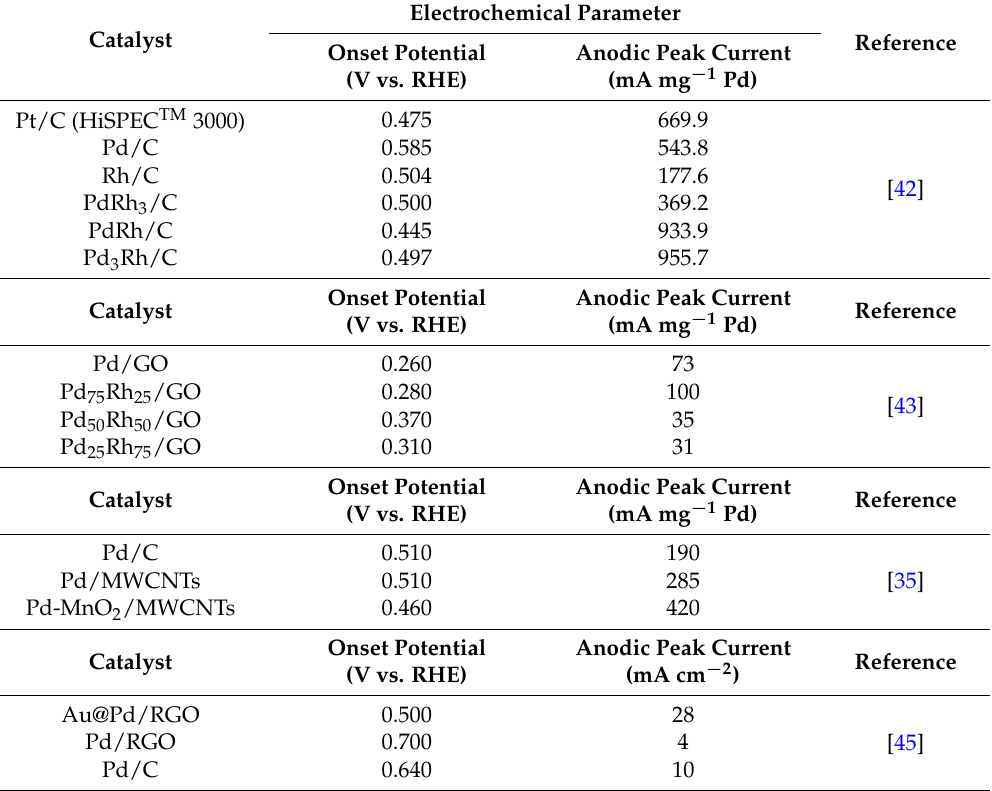
Table 4. Electrochemical properties of Pd-alloys supported on different carbon materials.